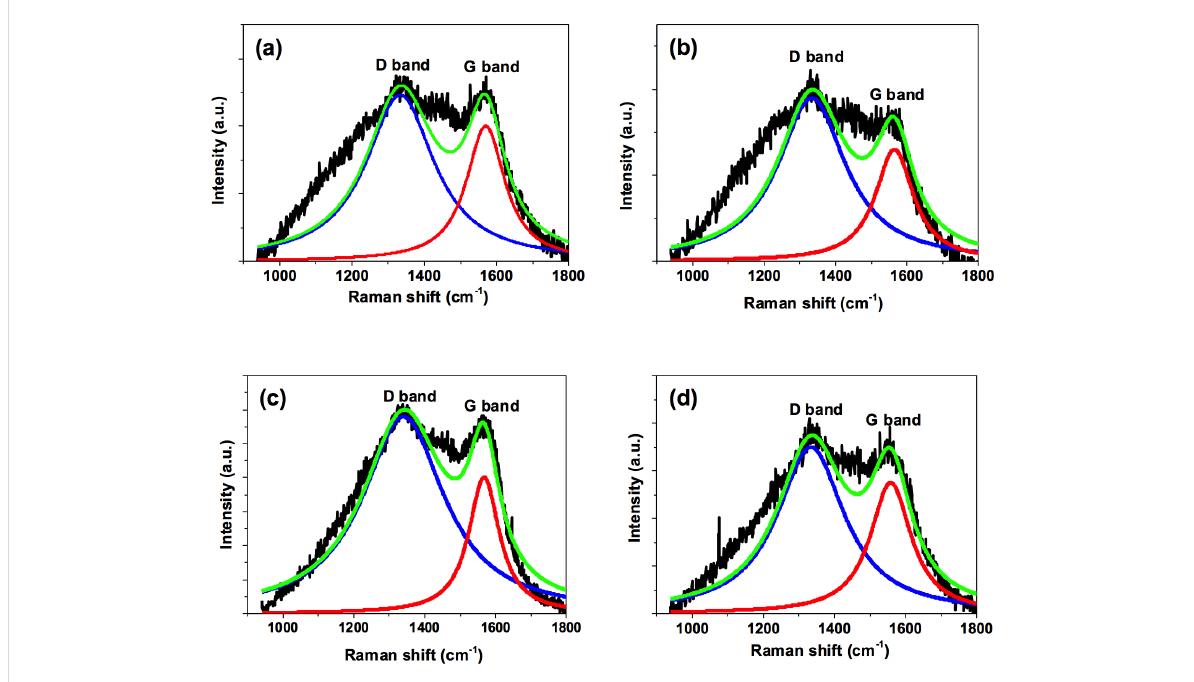
Figure 7: Raman spectra of (a) cinnamon C-dots, (b) red chilli C-dots, (c) turmeric C-dots and (d) black pepper C-dots.